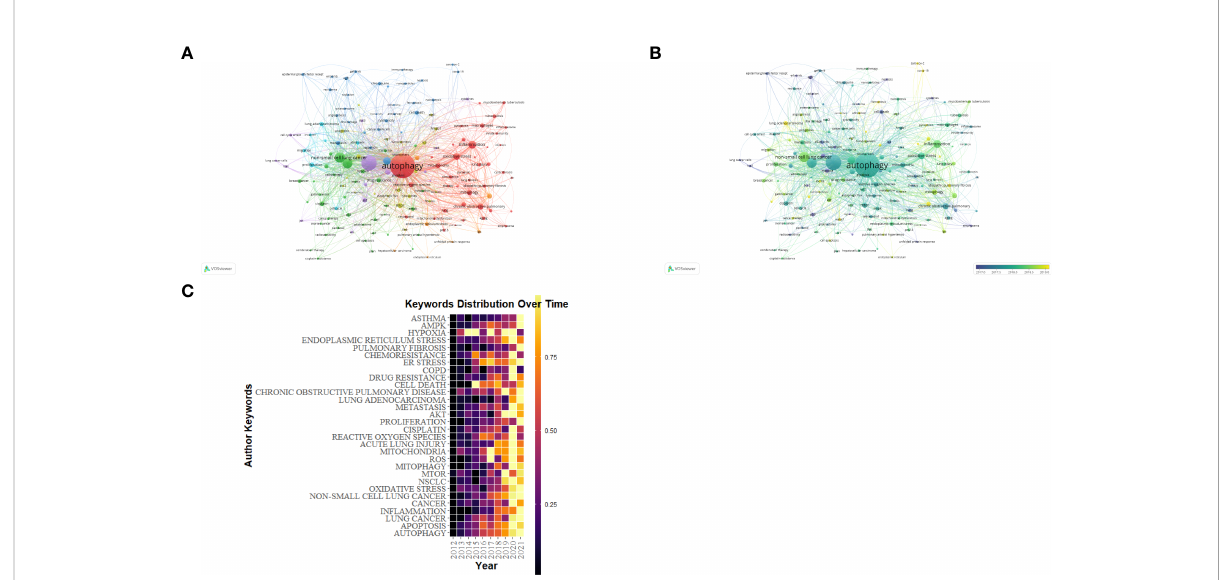
FIGURE 9 The keyword mapping of autophagy research in lung disease. (A) The 155 keywords appearing over 13 times fell into fi ve clusters based on colors: Cluster 1, 2, 3, 4, and 5 are, respectively, red, green, blue, yellow, and purple. The node size denotes the occurrence frequency. (B) Keywords visualization based on the APY. Keywords in cluster 4 occurred later than those in cluster 3. (C) Yearly occurrences of the top